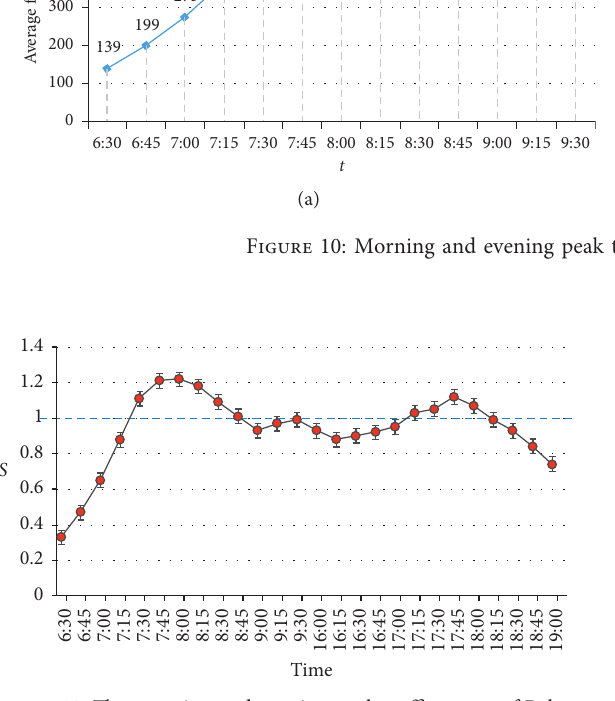
Figure 11: The morning and evening peak traffic status of Balong road